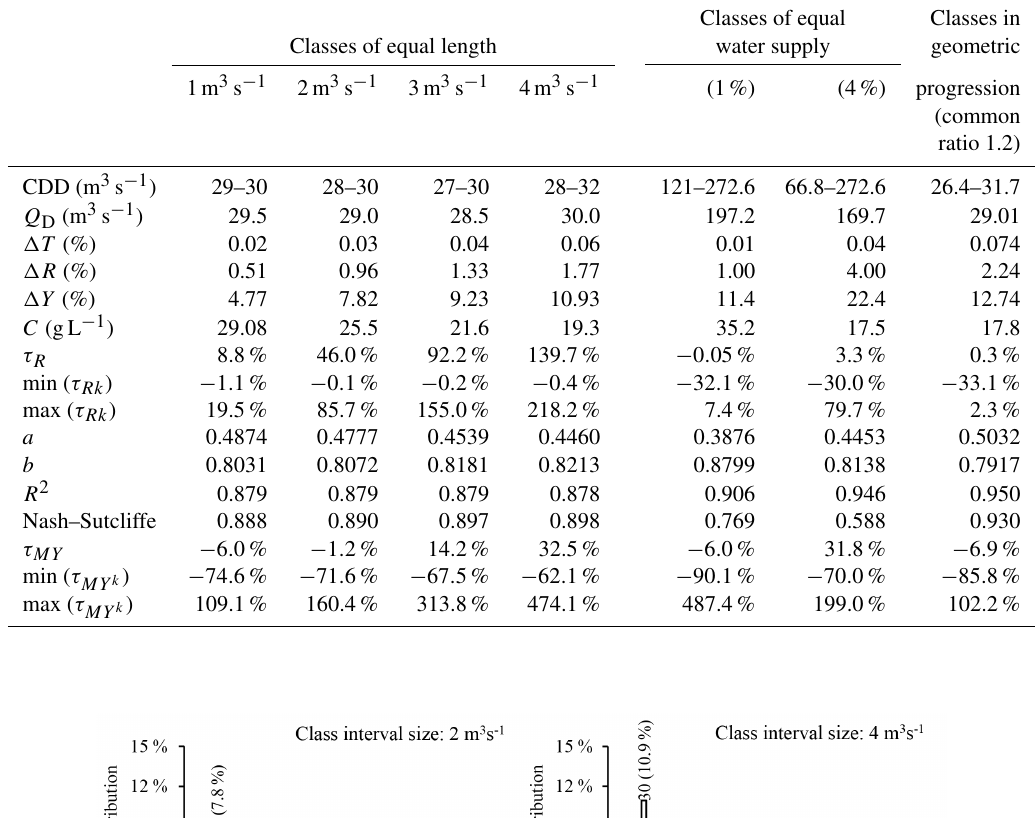
Table 1. Characteristics and performance of various subdivisions: class of dominant discharge range CDD; effective discharge; flow fre- quency (cid:49)T , water supply (cid:49)R , sediment supply (cid:49)Y and concentration C ; parameters of the rating curve C k = aQ kb ; discrepancies between water and sediment inputs obtained from classes and from elementary contributions.